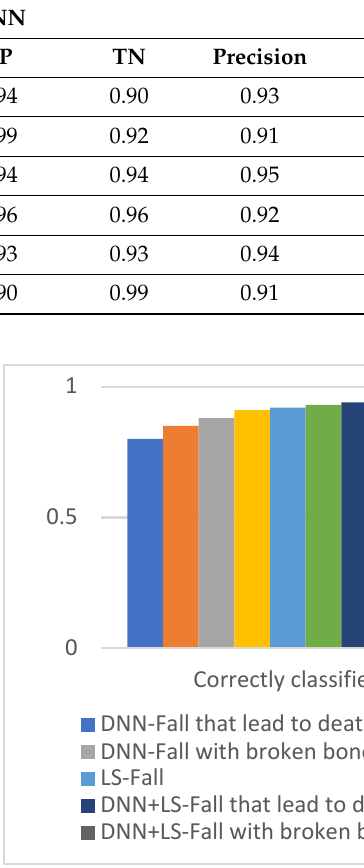
Table 8. Comparison of performance results with different numbers of clusters from the C-Means (N) for the SV-S2017 set.